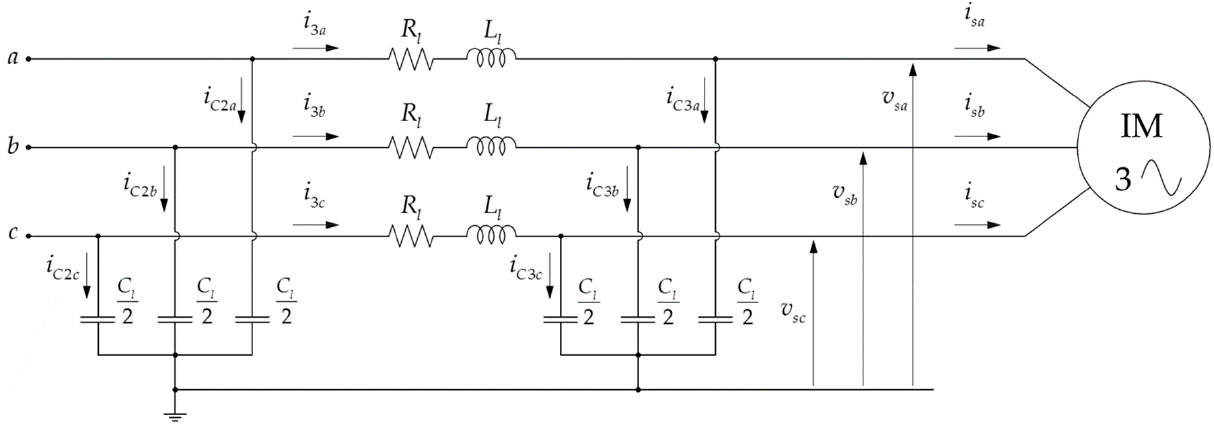
Figure 7. Long cable three-phase model.